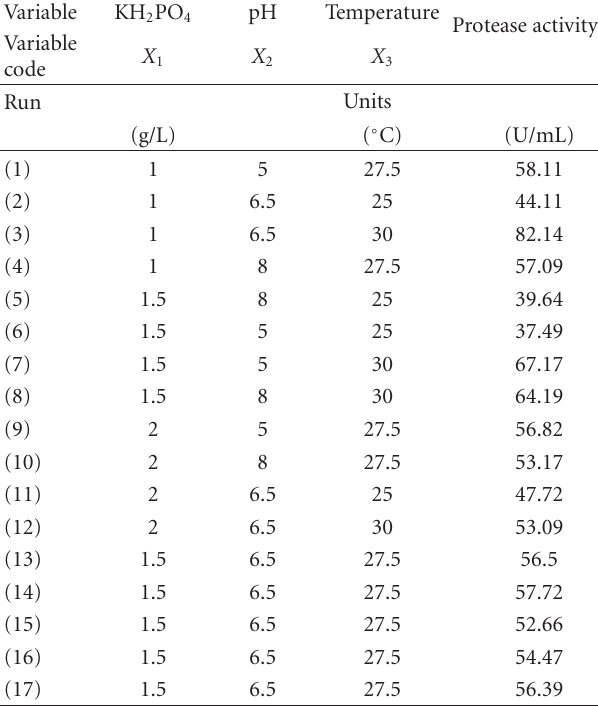
Table 3: The Box-Behnken design of RSM for optimization of pro- tease production.